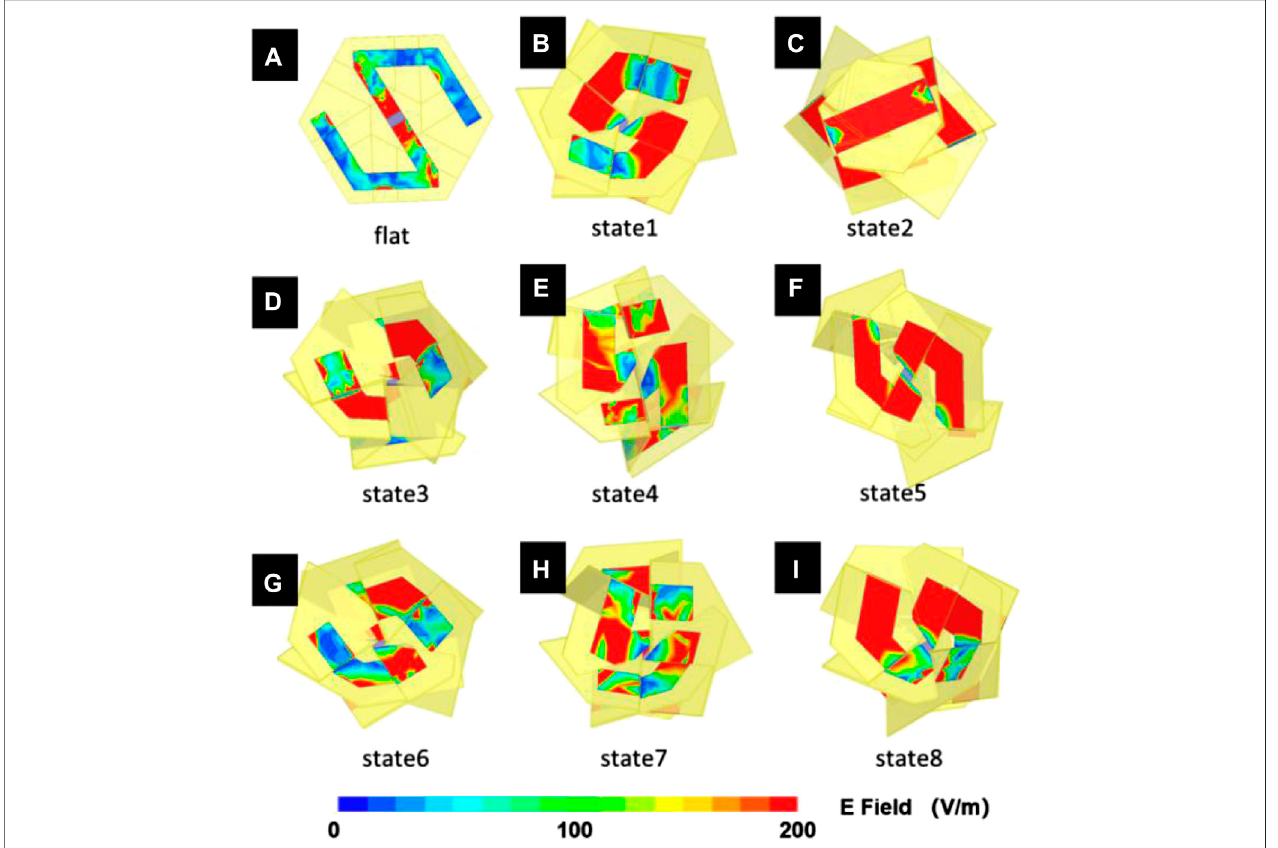
FIGURE 7 | The current distribution fi nite element simulation results of the hexagon-twist origami structure stable (A) fl at state and (B – I) state 1 – 8.